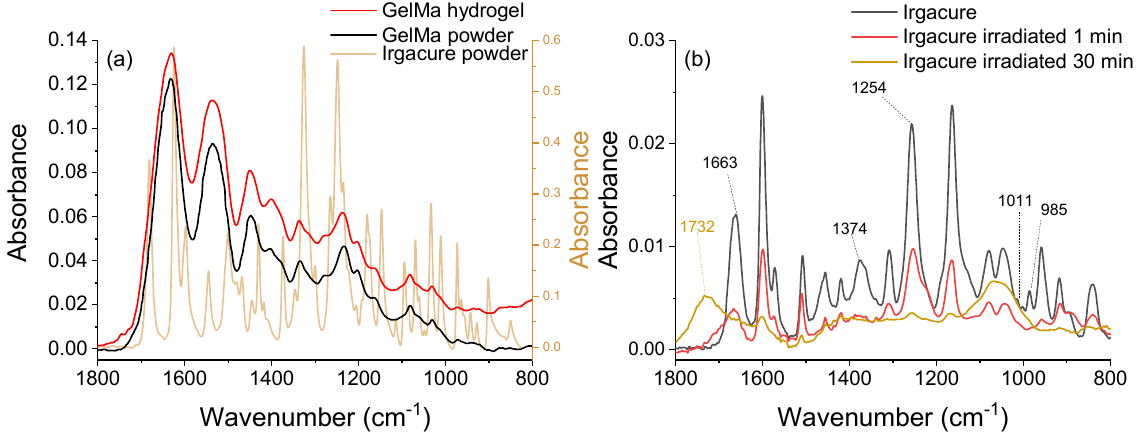
Figure 7. FTIR spectra of ( a ) Irgacure 2959 powder, GelMa powder, and dried GelMa hydrogel (Irgacure 0.05% and GelMa 10% w / v ) resulting after the irradiation with 0.75 mJ pulsed laser beams for 1 min, ( b ) Irgacure at concentration 0.05% exposed to 266 nm laser pulsed radiation at energy 0.75 mJ for 1 min and 30 min.